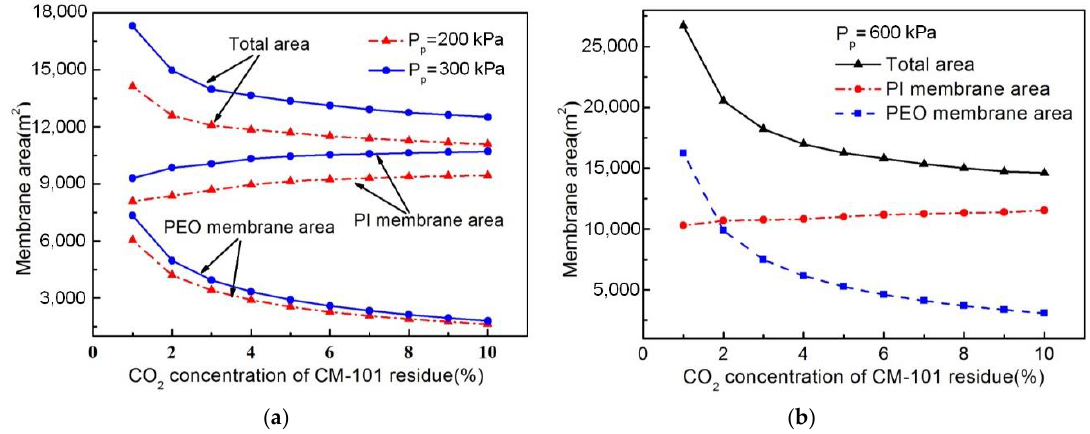
Figure 5. E ff ect of CO 2 concentration of CM-101 residue on membrane area under di ff erent permeate Figure 5. Effect of CO 2 concentration of CM-101 residue on membrane area under different permeate pressures. ( a ) Diagram under 200 and 300 kPa; ( b ) diagram under 600 pressures. ( a ) Diagram under 200 and 300 kPa; ( b ) diagram under 600 kPa.